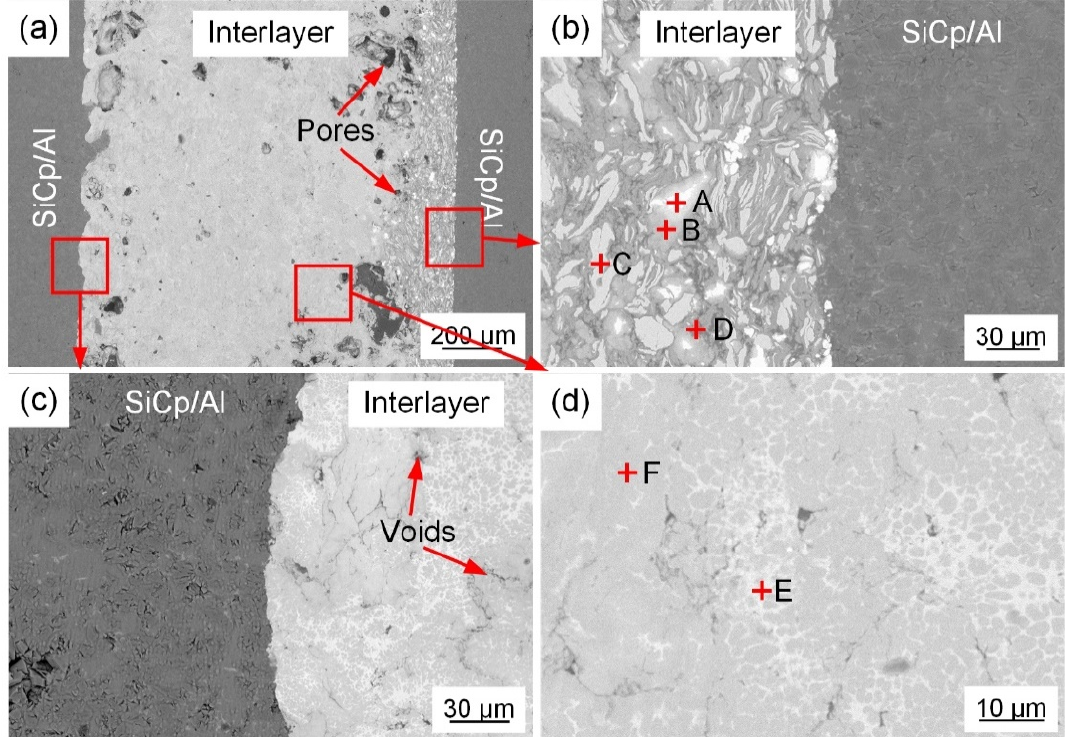
Figure 9. Microstructure of joint bonded with Al/Ni/Zr interlayer (10 wt.% Zr). ( a ) Overall joint; ( b ) interface on right side; ( c ) interface on left side; ( d ) joint center.